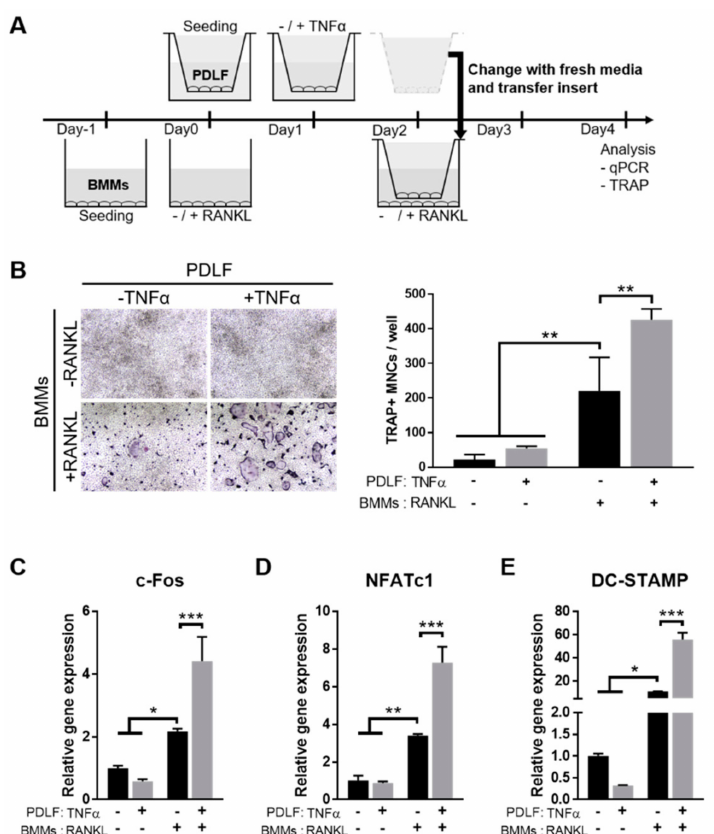
Figure 3. The TNF α -stimulated PDLF showed increased osteoclastogenesis-supporting activity ( A ) A schematic diagram of the experimental procedure. PDLF (upper chamber) was activated with TNF α for 24 h prior to co-culture with BMMs (lower chamber). In this co-culture system, osteoclast differentiation was allowed in the presence or absence of 100 ng/mL of RANKL as indicated. ( B ) Representative images of TRAP staining (left) and quantitative analysis (right) of TRAP-positive MNCs. ( C – E ) The expression of osteoclastogenic markers including c-FOS, NFATc1, and DC-STAMP in BMMs was determined by qPCR and normalized to the expression levels of β -actin. Data represent the mean ± S.E.M. * p < 0.05, ** p < 0.01, and *** p < 0.001 by two-way ANOVA. MNCs, mononuclear cells.